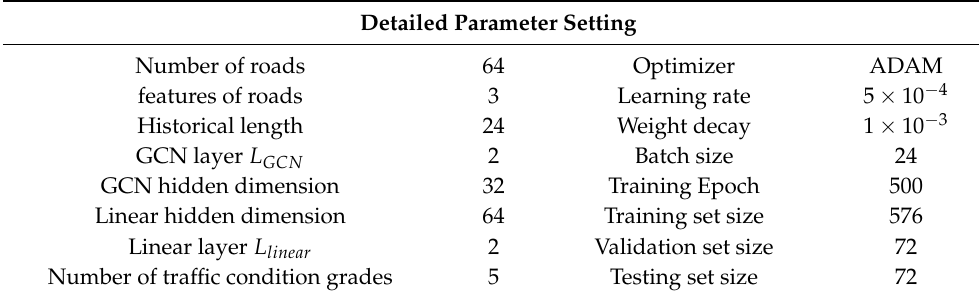
Table 2. Hyperparameters and training parameters of the environmental perceiver.